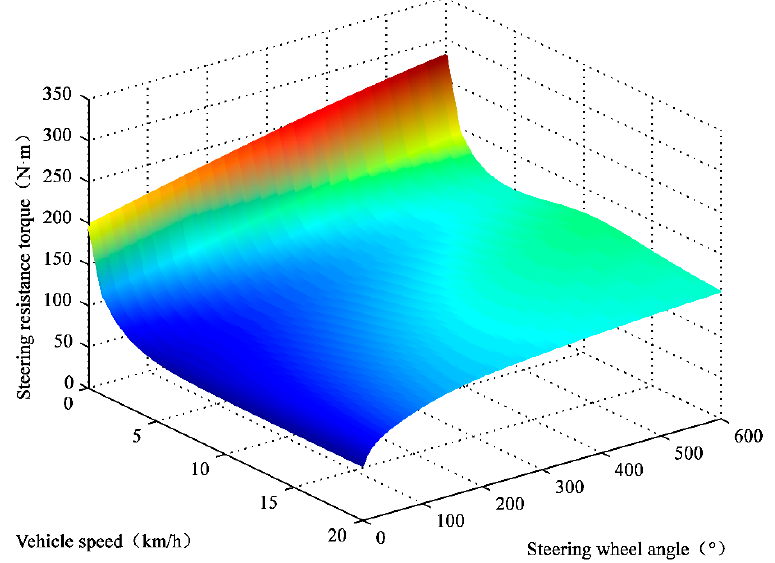
Figure 11. 3D surface plot of the low-speed steering resistance torque.